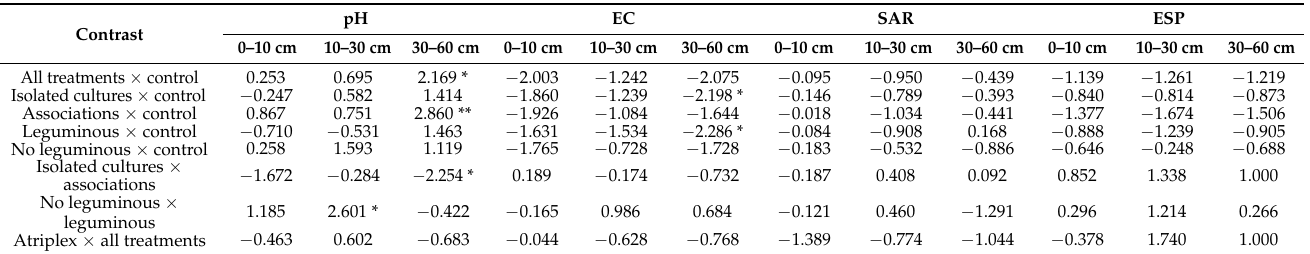
Table 3. Orthogonal contrasts of chemical attributes pH (potential of hydrogen), EC (electrical conductivity), SAR (sodium adsorption ratio), and ESP (exchangeable sodium percentage) in the soil at 0–10, 10–30, and 30–60 cm depth as a function of applied treatments at 9 months.